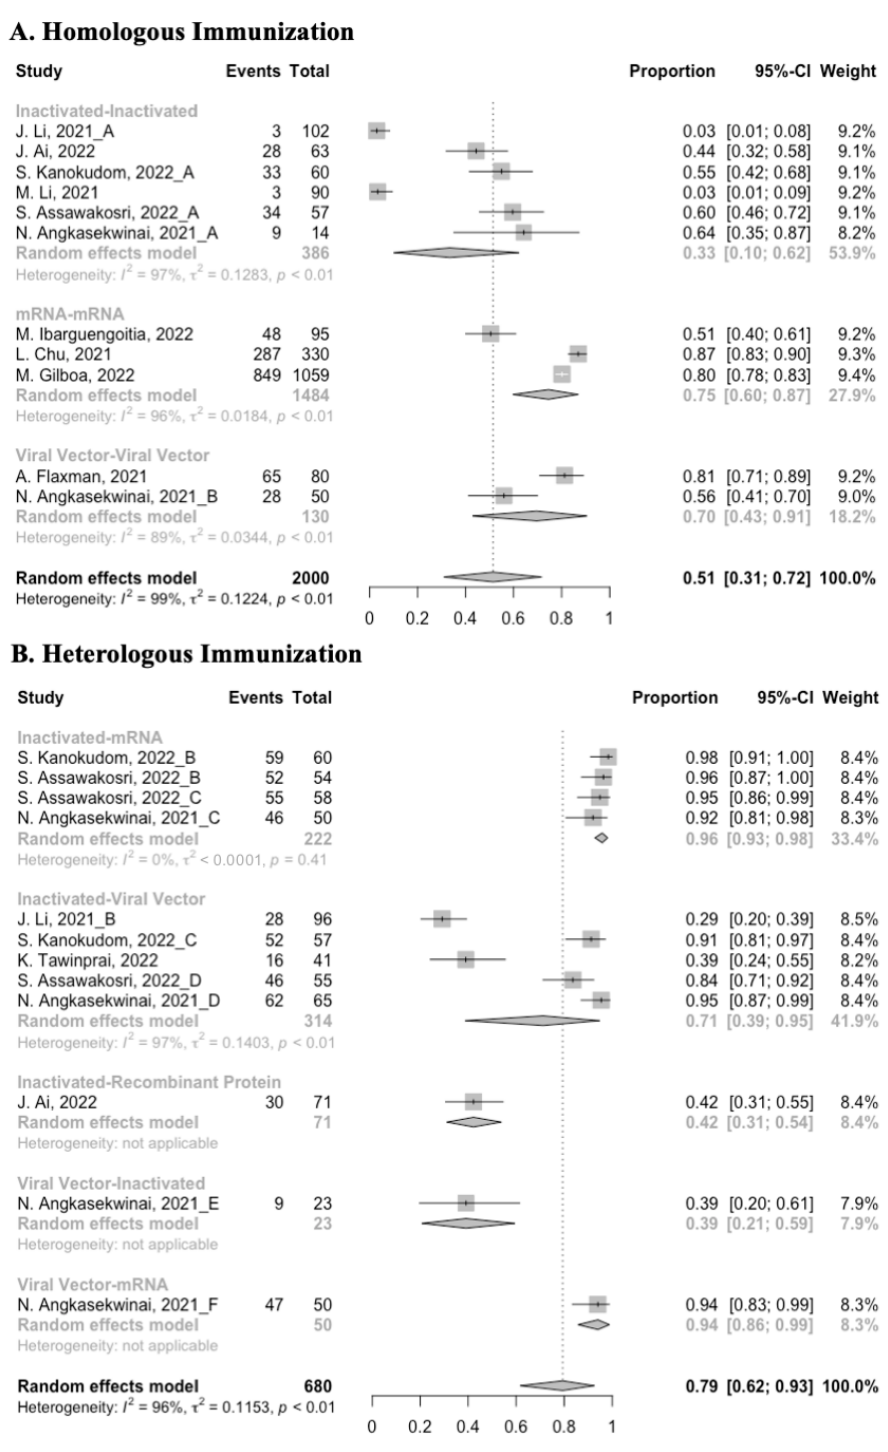
Figure 12. Forest plot of the overall incidence of local adverse events after booster vaccination.